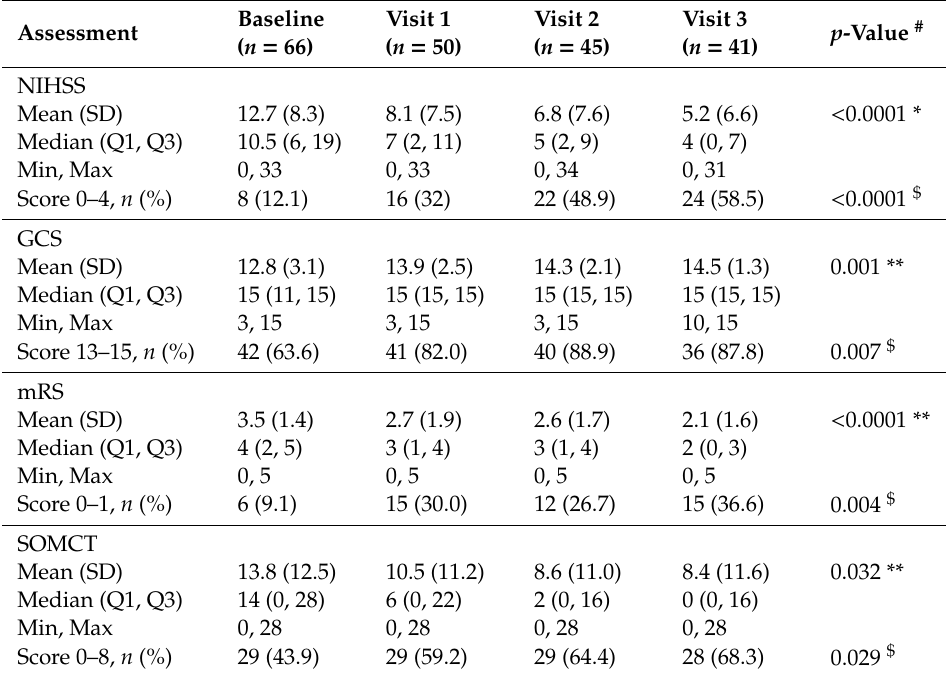
Table 2. Outcome assessments at baseline and visits 1 to